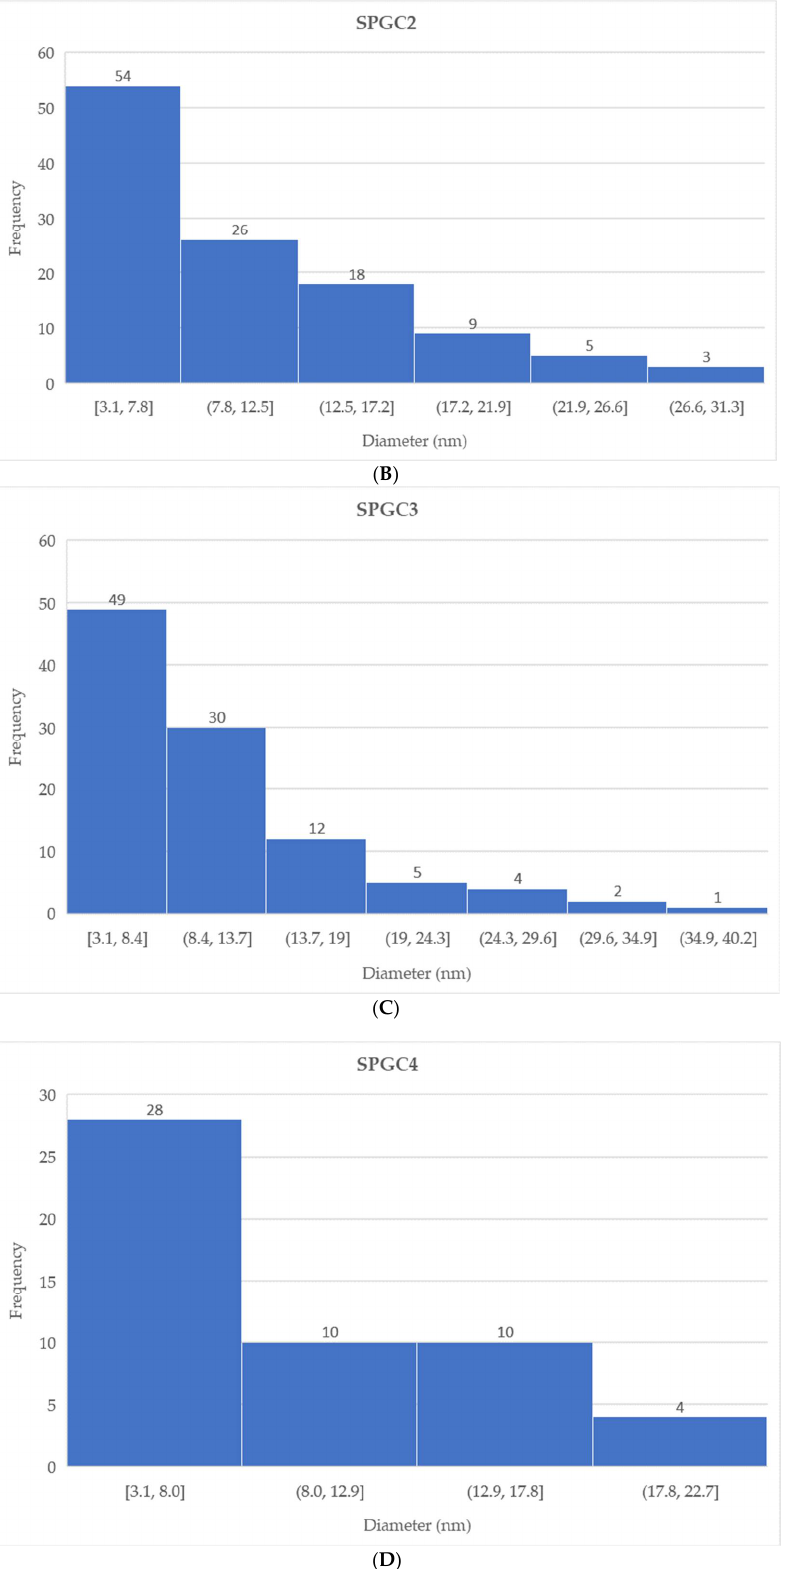
Figure 9. The number and size of starch granules cluster as the citric acid content of the solution increases, ( A ) 0.46 wt% CA (SPGC1), ( B ) 0.92 wt% CA (SPGC2), ( C ) 1.38 wt% CA (SPGC3), ( D ) 1.83 wt% CA (SPGC4).